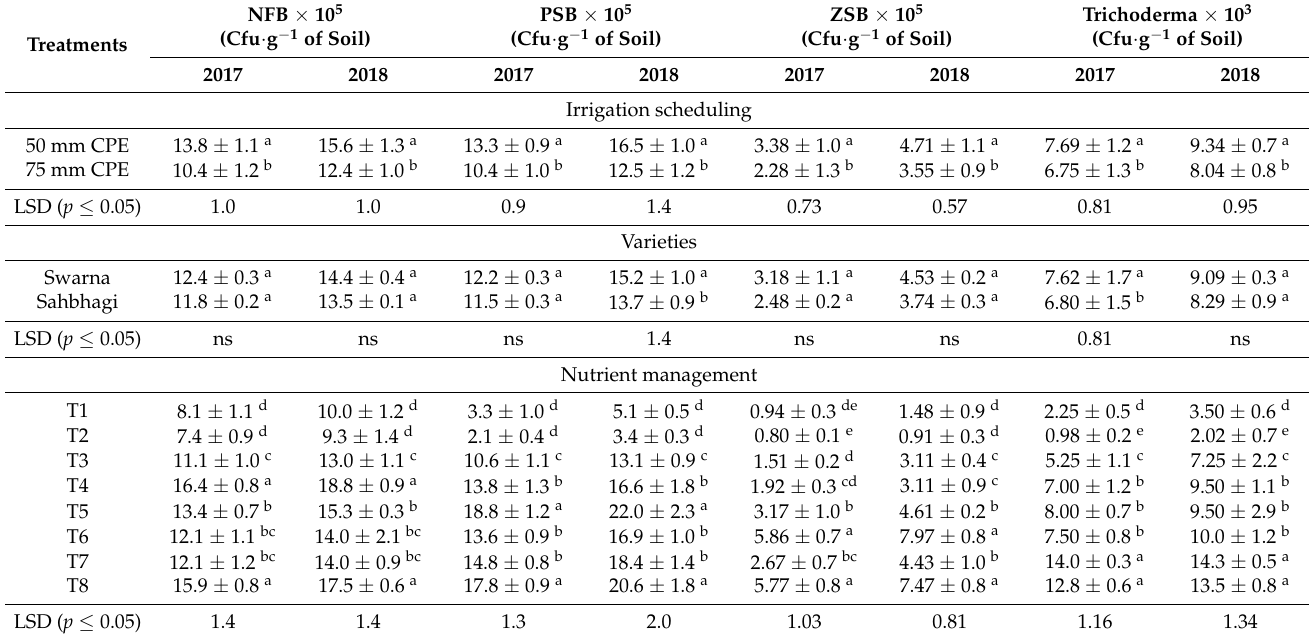
Table 6. Soil microbial population as influenced by varied irrigation levels, varieties and nutrient management practices along with microbes.